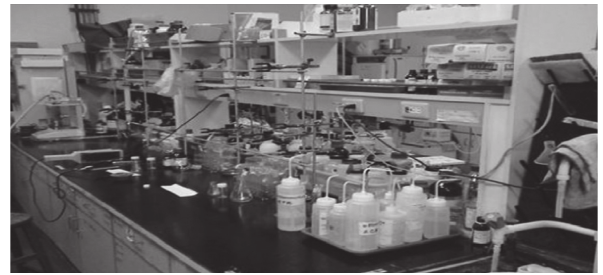
Figure 7: Experimental environment.